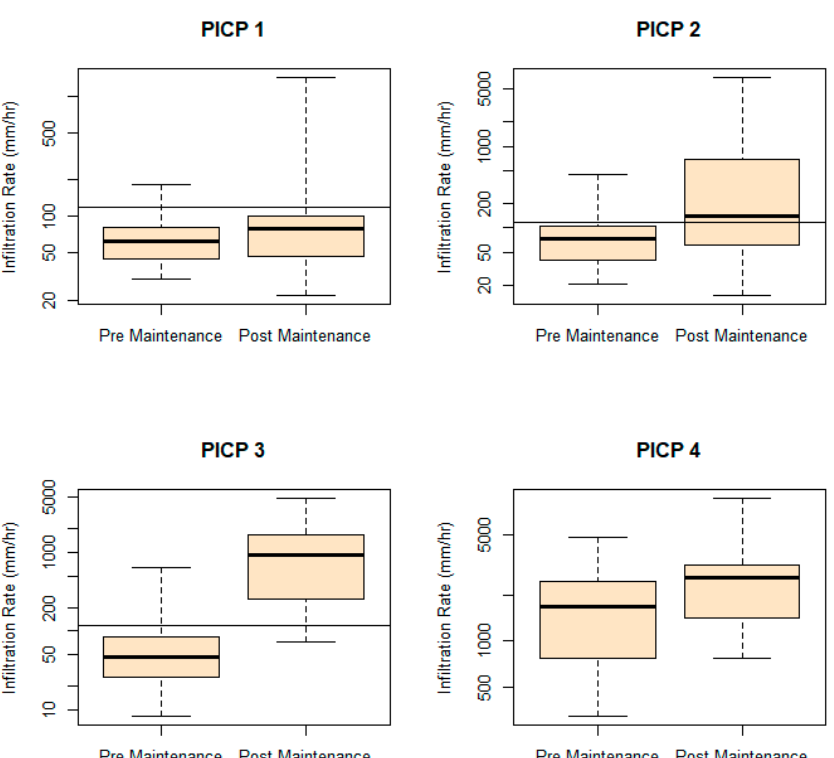
Figure 7. Censored Box plot for PICP sections. Note: The horizonal line in the box plots represents the highest minimum detection limit (MDL) of the dataset with multiple censoring limits. Kaplan-Meier (KM) percentiles are plotted for values below the detection limit.